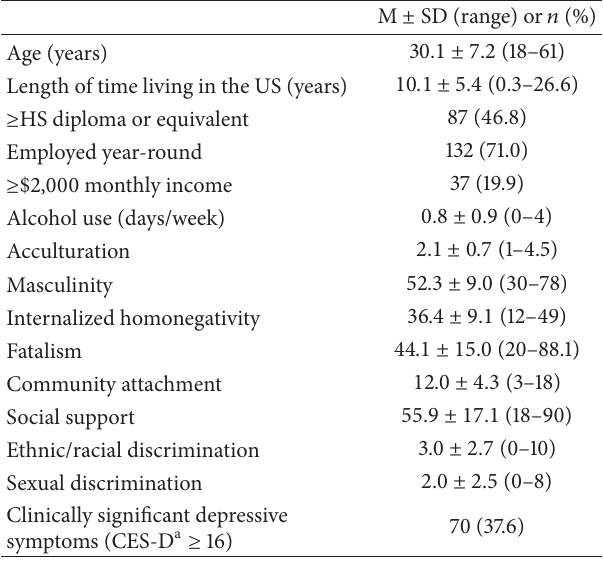
Table 1: Participant